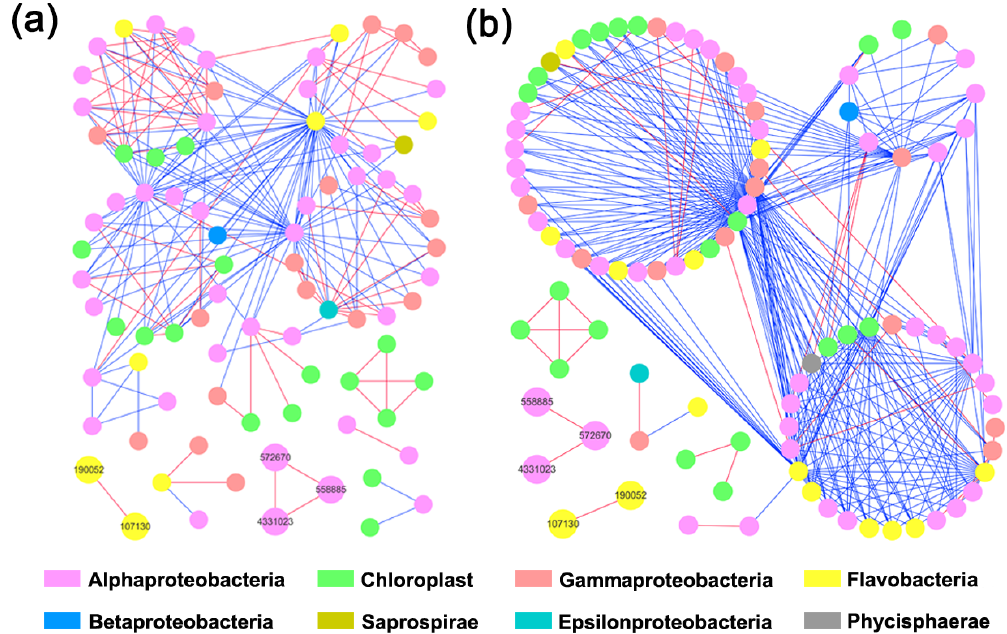
Figure 4. Bacterioplankton network interactions under LC (a) and HC (b) conditions. Each node represents an OTU. Node colors denote different taxa. Each line connects two OTUs. A blue line indicates a negative interaction between nodes, suggesting predation or competition, while a red line indicates a positive interaction suggesting mutualism or cooperation. Important OTUs are marked with OTU identification numbers.